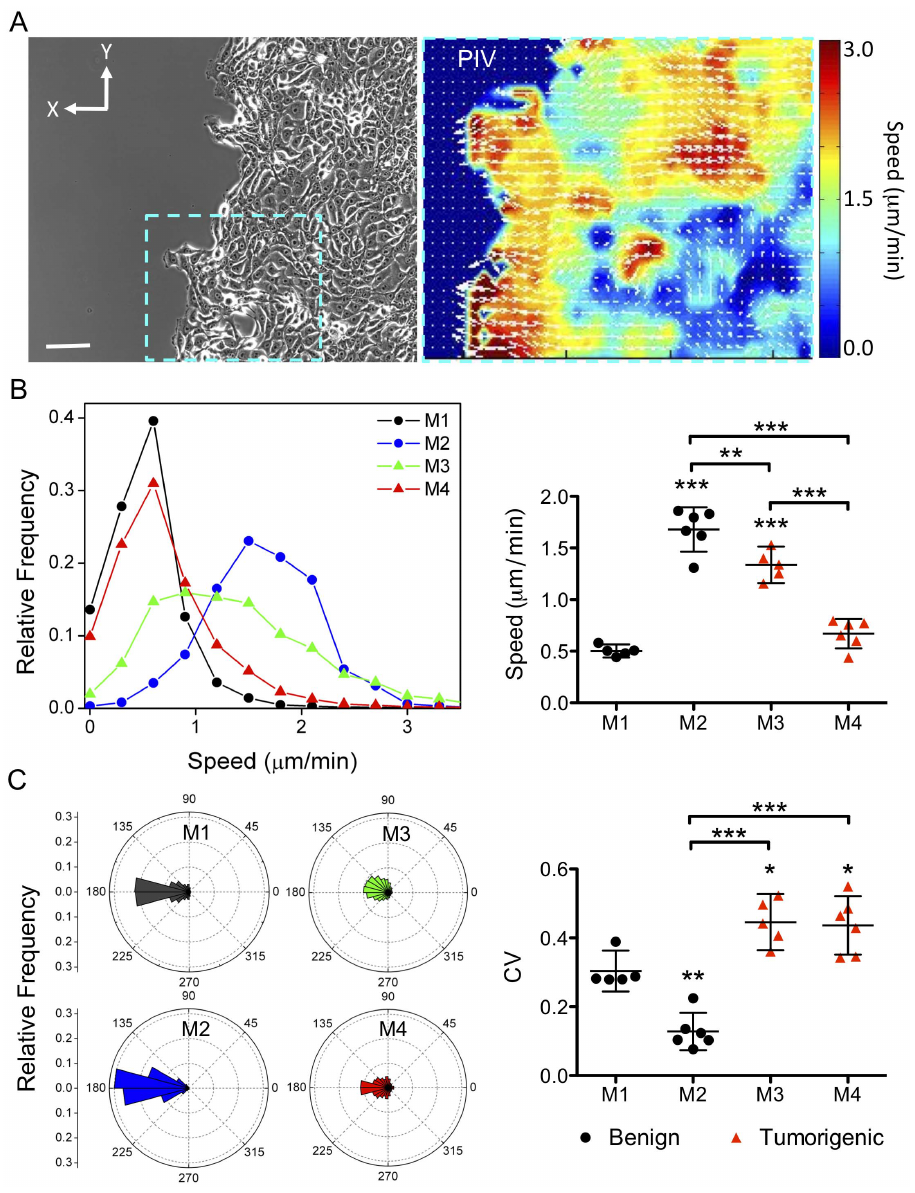
Figure 2. Cell lines of the MCF10A series show distinct migration speed and directionality. ( A ) PIV analysis enables the mapping of velocity fields associated with the underlying epithelial sheet motions captured by phase time-lapse imaging (scale bar =100 m m). Spatial profiles of directionality and speed are depicted with white vectors and a heat map, respectively (right panel). ( B ) Left: Aggregate speed distributions, determined over all times and space, were compiled from 5–6 independent experiments for each cell line. Right: Quantification of the mean of the average speed (mean 6 95% CI) for each cell line; M1–M2 (benign, black circles) and M3–M4 (tumorigenic, red triangles). ( C ) Left: Rose plots depicting aggregate directionality distributions were compiled over all times and space for each cell line (n=5–6). Right: Variability of the direction of motion was quantified by the coefficient of variation (CV) and reported as mean 6 95% CI. Statistical significance: * p , 0.05, ** p , 0.01, *** p , 0.001 (Tukey- Kramer test, n=5–6). All comparisons were made with M1 cells unless indicated by pairing-brackets.